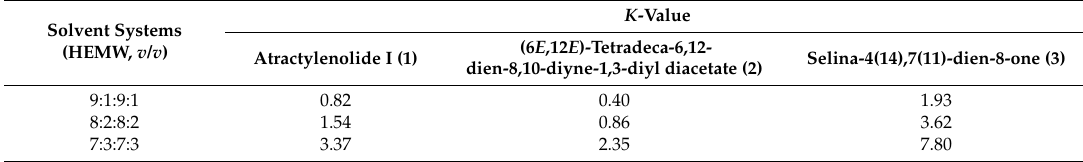
Table 1. Partition coefficients ( K ) of n- hexane fraction of A. macrocephala. Solvent Systems (HEMW, v / v